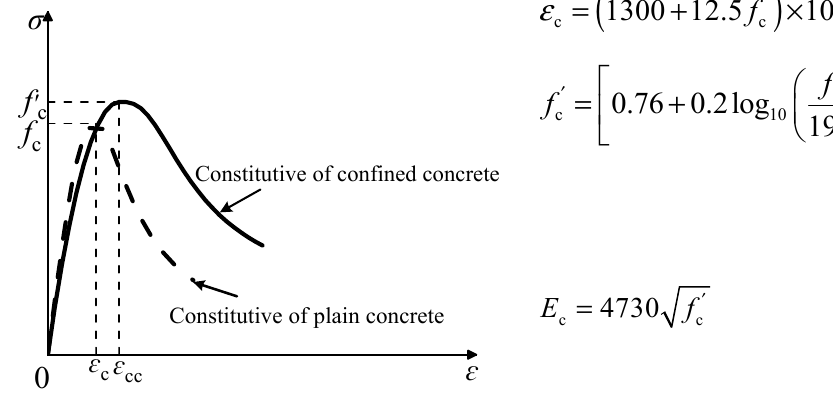
Figure 4. Stress–strain curves of concrete.